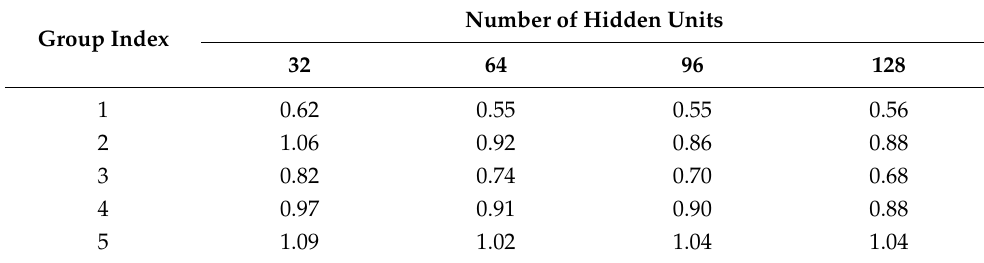
Table 3. RMSE of different network parameters (units: degree). Group